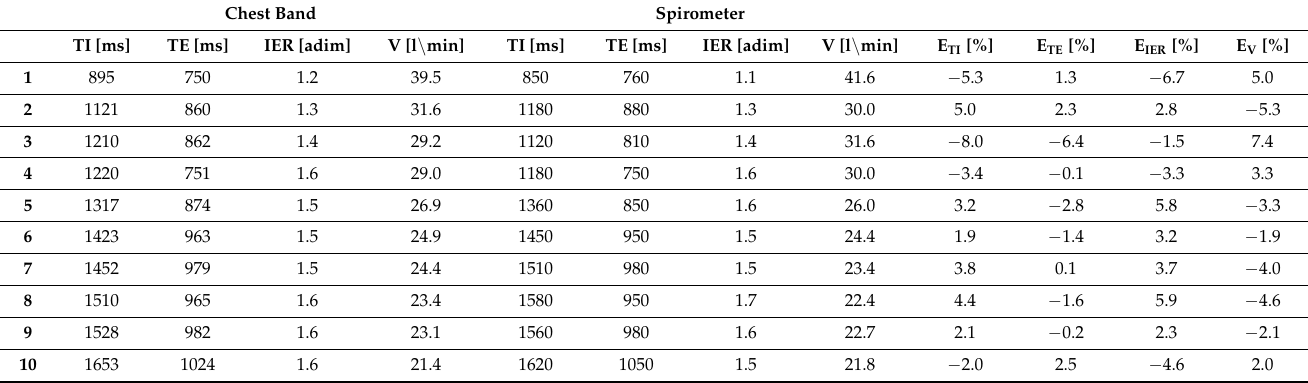
Table 2. Comparison of the measurements of TI, TE, IER, and V with the reference values provided by a